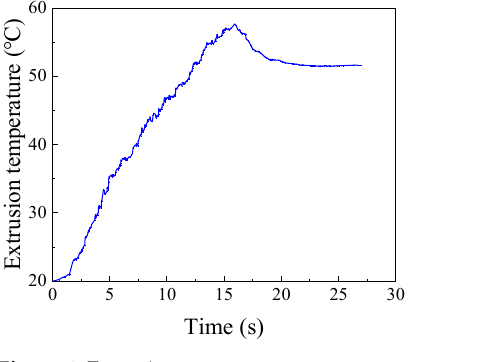
Figure 6. Extrusion